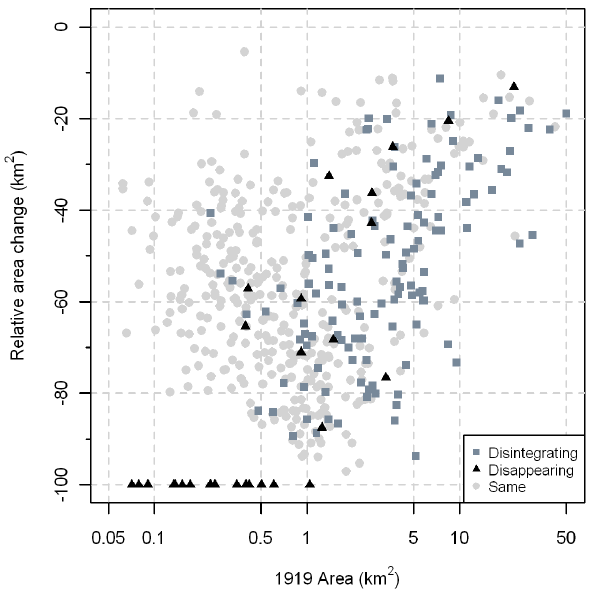
Fig. 6. Plot of 1919–2006 relative area change versus 1919 glacier area. Data are separated into three groups: flowsheds with an in- crease in the number of ice masses (disintegrating); flowsheds with a decrease in the number of ice masses (disappearing); and no change (same).